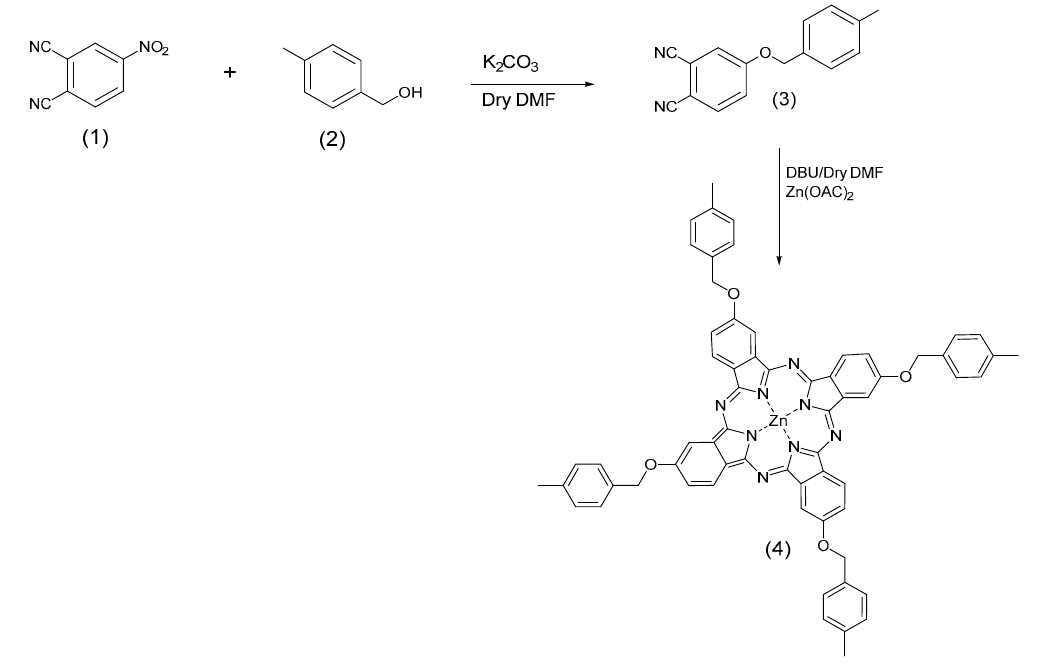
Figure 3. Two-step synthesis of the ZnPcBCH 3 sensitizer ( 4 ).